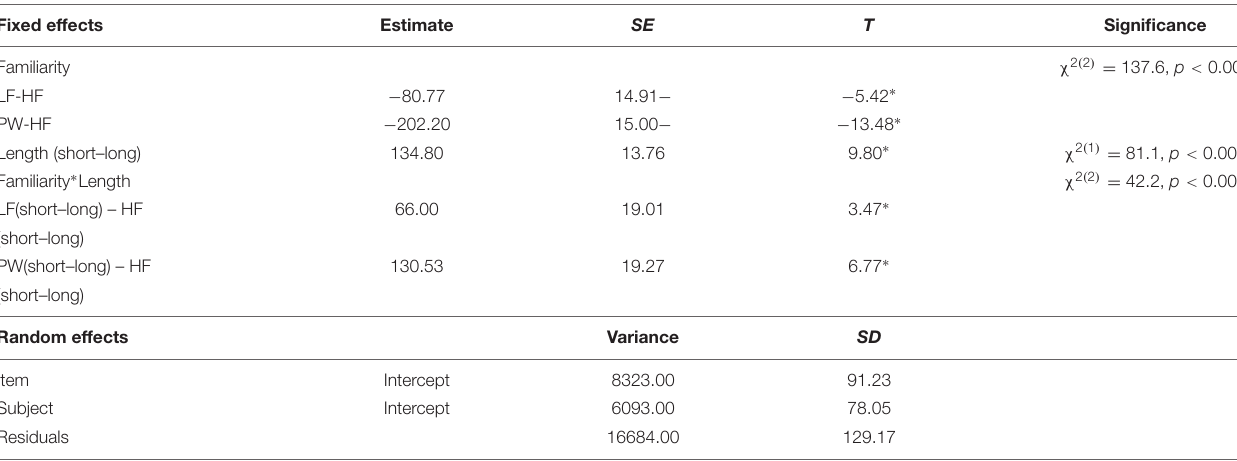
TABLE 2 | Predictors of offset EVS.